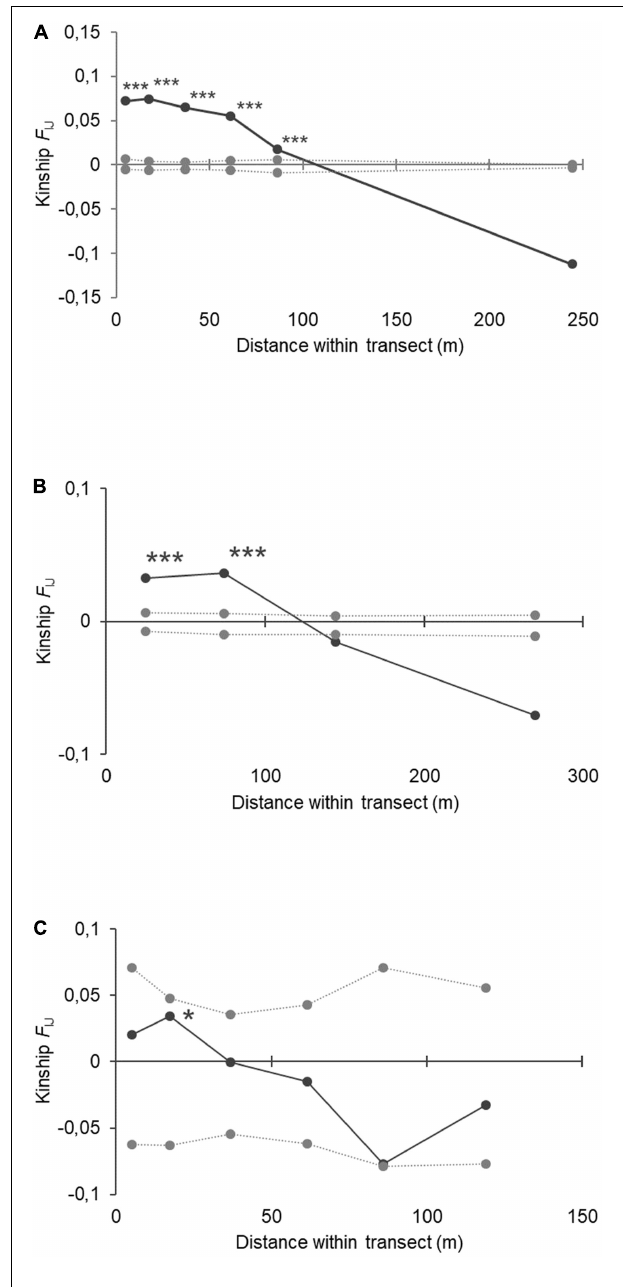
FIGURE 3 | Fine-scale genetic structure within transects for panel (A) Avicennia marina populations ( N = 16); (B) Avicennia rumphiana populations ( N = 6) and (C) Avicennia alba populations ( N = 2) from mangroves in The Philippines. Distance classes showed significant kinship ( F IJ ) values to 100 m in A. marina and 60 m in A. rumphiana (*** for p < 0.001; * for p < 0.05). The log-slope of the regression over full distance was b = − 0.050 ( p < 0.001), -0,028( p < 0.001), and -0,019 ( p < 0.05) respectively for the three species.